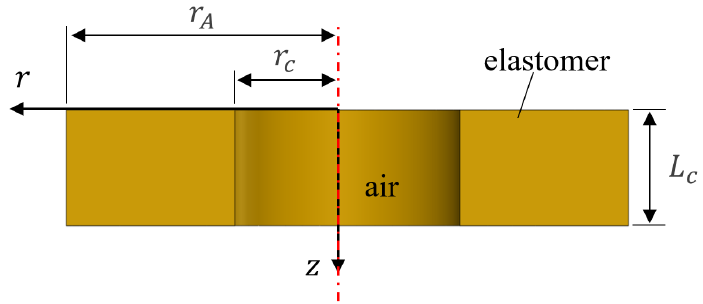
Figure 4. Profile of a section with an air-filled cavity.